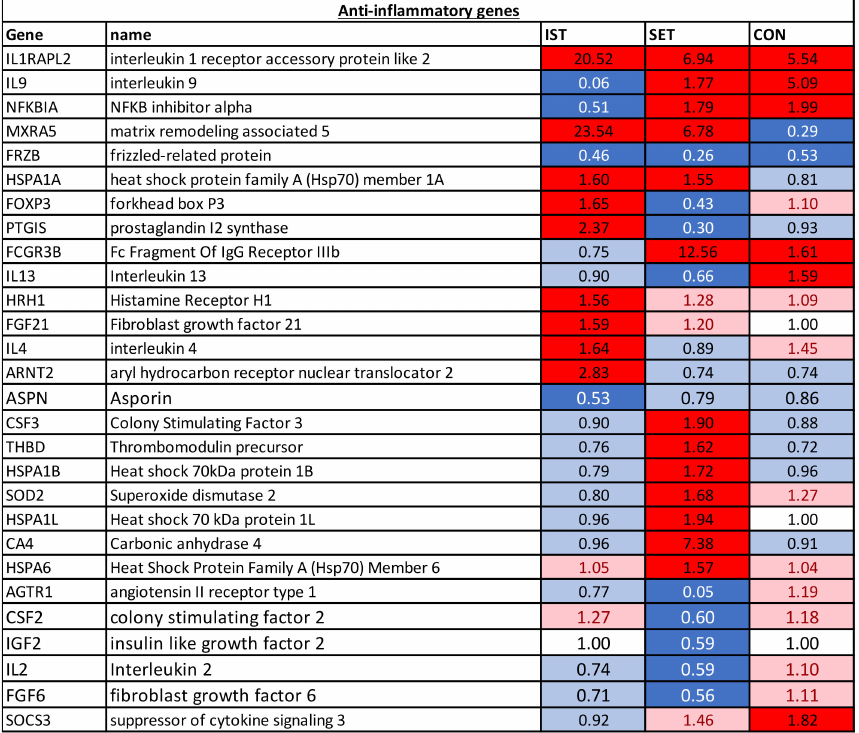
Figure 4. Anti-inflammatory genes of which the expression was changed significantly in at least one of the groups. FC of the genes represent the change from baseline to 3 months intervention. Dark blue: genes that were downregulated after the intervention (FC of ≤ 0.67). Light blue: genes showing a tendency towards downregulation after the intervention (1 > FC < 0.67). White: genes of which expression was not altered after the intervention (FC = 1); Pink: genes showing a tendency towards upregulation after the intervention (1 < FC < 1.5). Red: genes that were upregulated after the intervention (FC ≥ 1.5).